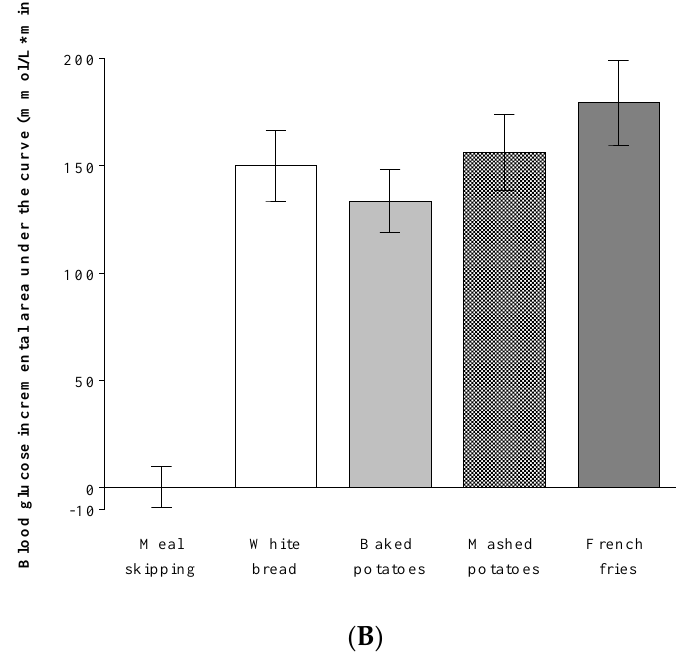
Figure 2. ( A ) Effect of treatment on blood glucose over 120 min. Blood glucose concentrations were affected by treatment ( p < 0.001), time ( p < 0.001), and treatment by time interaction ( p < 0.001). Blood glucose concentrations were higher after all test treatments compared with meal skipping ( p < 0.001), but did not differ from each other. ( B ) Effect of treatment on blood glucose incremental area under the curve (iAUC). Blood glucose iAUC was affected by treatment ( p < 0.001), where iAUCs were higher after all test treatments compared with meal skipping. All values are means ± SEM, n = 20.